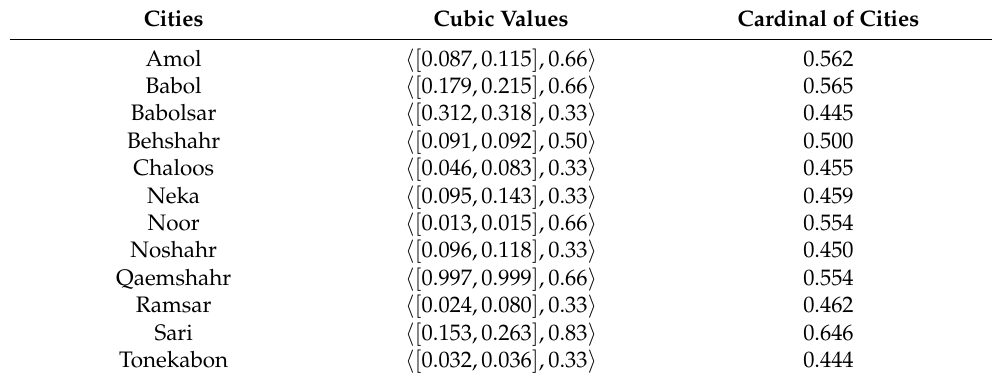
Table 6. Cubic values and cardinal of cities.